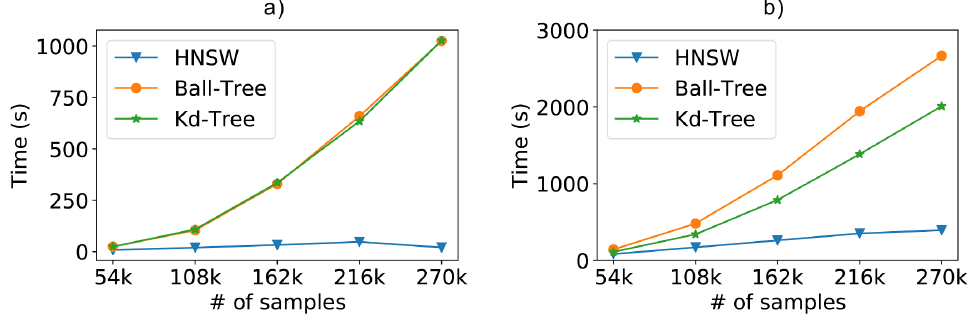
Figure 10. Scalability evaluation including the ( a ) model fitting time; ( b ) the total time